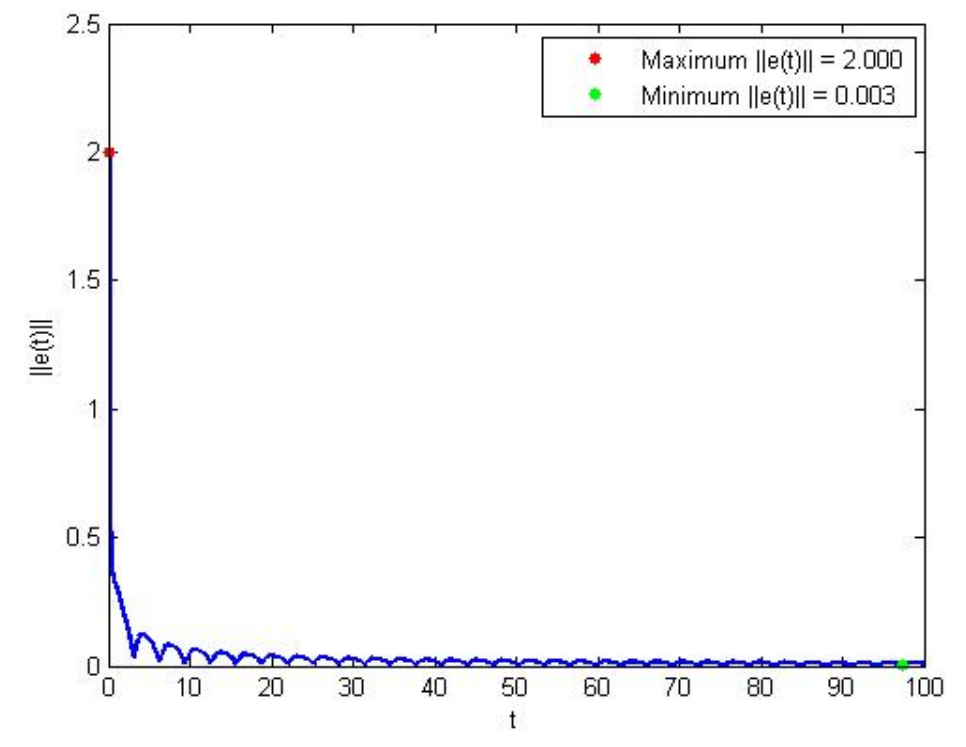
Figure 13. || e ( t ) || for system (10), with α = 0.5, ρ = 1.5, and w ( t ) = [ 2 sin ( t )] T . Figure 13. ‖𝑒(𝑡)‖ for system (10), with 𝛼 = 0.5 , 𝜌 = 1.5, and 𝑤(𝑡) = [2 𝑠𝑖𝑛(𝑡)] 𝑇 .